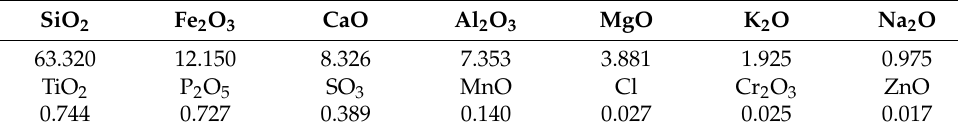
Table 1. Chemical element analysis of overflow ultra-fine iron tailings,